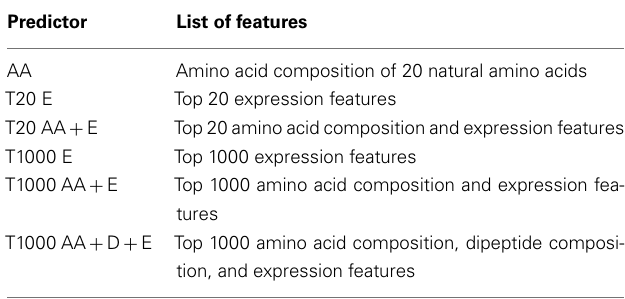
Table 1 |Types of predictors tested and their underlying